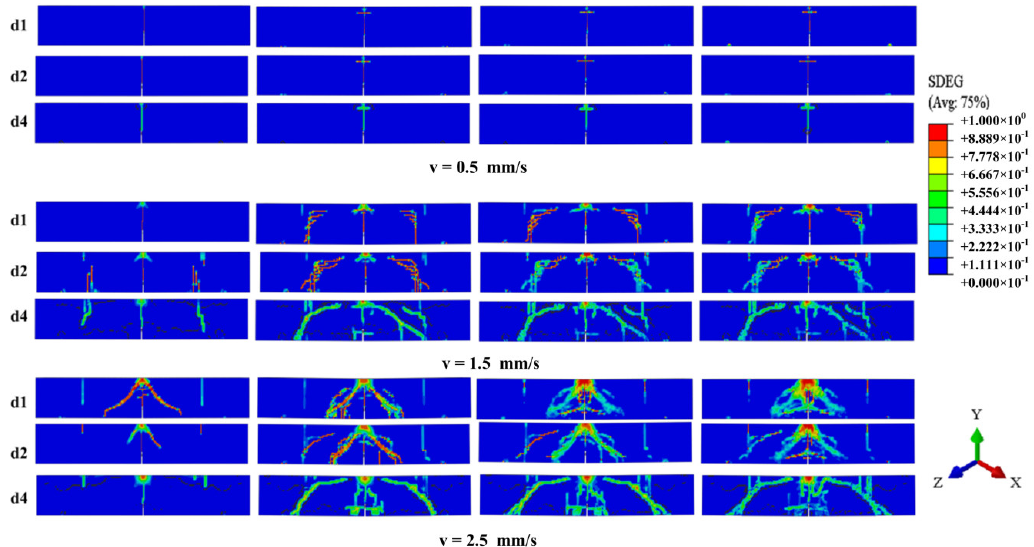
Figure 13. The dynamic failure process of reinforced concrete beams with different bonding area.